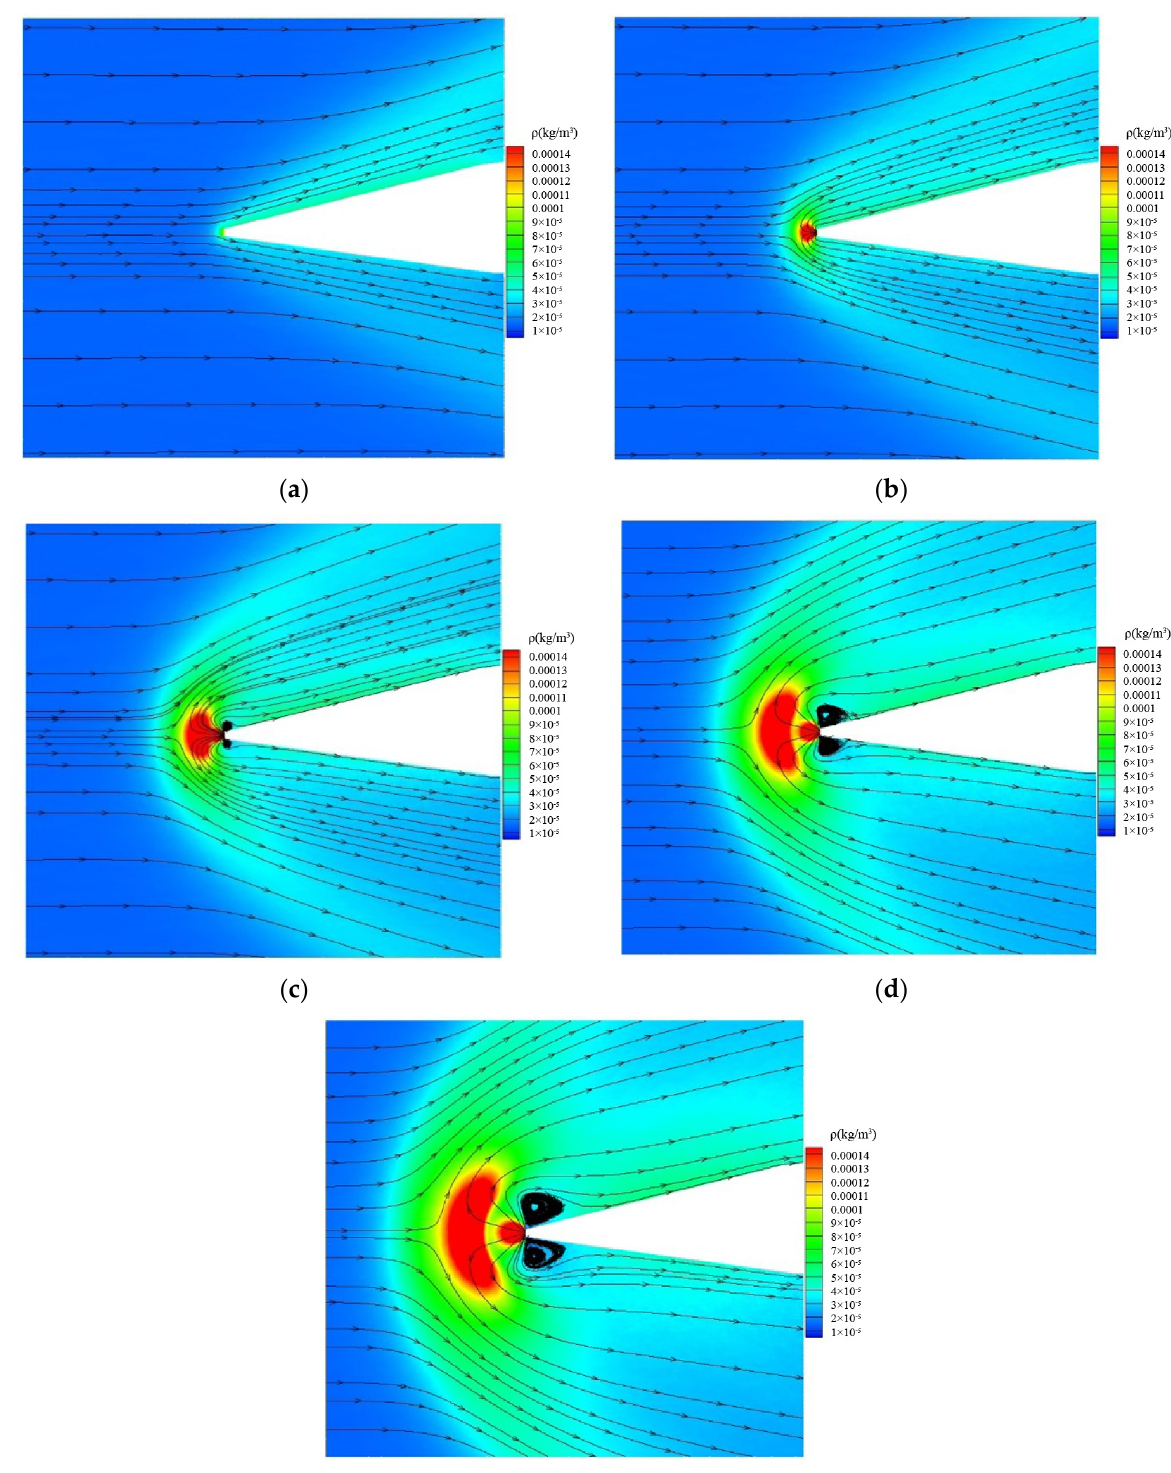
Figure 15. Contour of density nephogram and streamline of truncated cone: ( a ) No opposing jet; ( b ) PR = 0.2; ( c ) PR = 0.4; ( d ) PR = 0.6; ( e ) PR = 0.8.